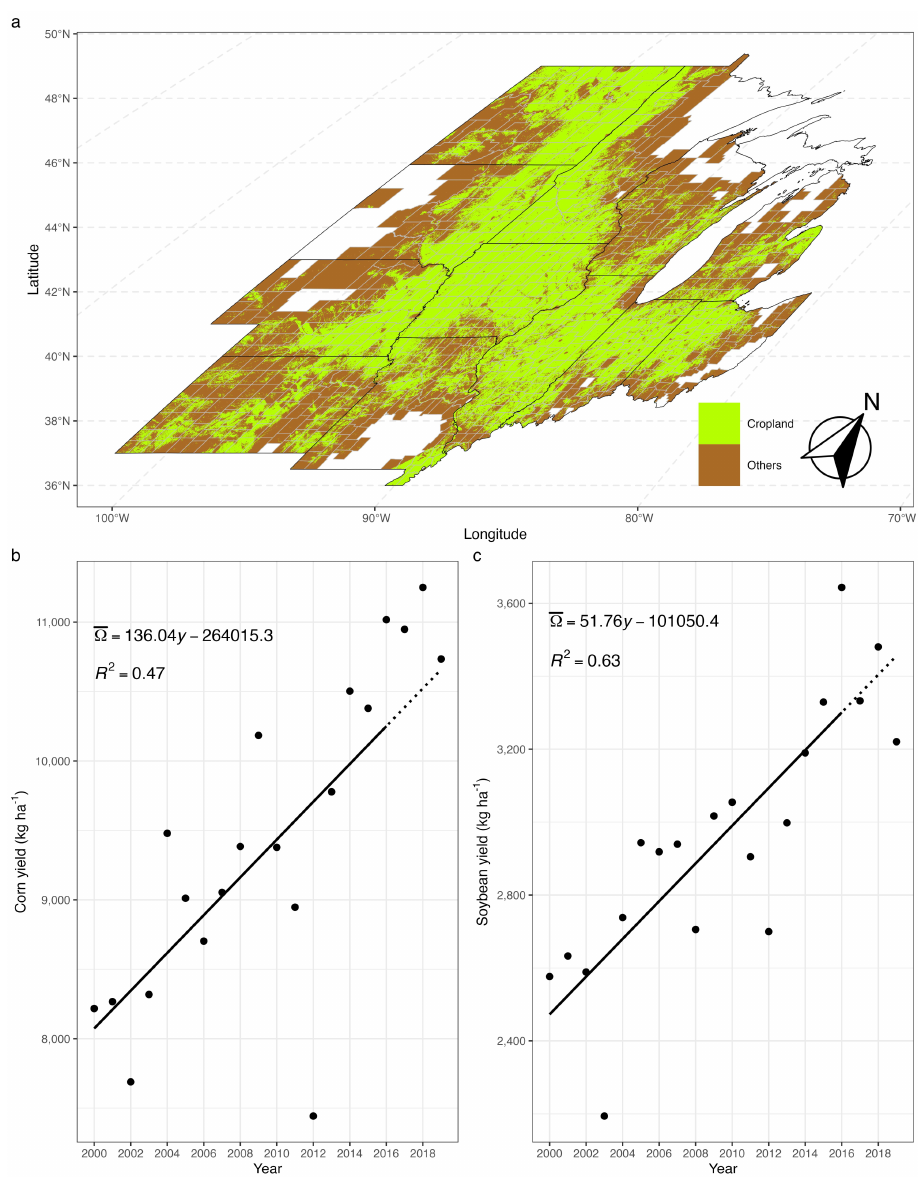
Figure 1. The counties where the regional trend and the relative residuals of crop yield were determined from 2010 to 2019. The region of interest encompasses 951 counties in 12 states: ( a ) The cropland mask was derived from the International Geosphere-Biosphere Programme land cover classification of MCD12Q1 product, which is a land use product of Moderate Resolution Imaging Spectroradiometer (MODIS) data. The regional trend of crop yield for ( b ) corn and ( c ) soybean was derived for the period from 2000–2016, which was indicated by the solid line. The dotted line indicates the extension of the regression line, which was used to predict the regional trend of crop yield during the period from